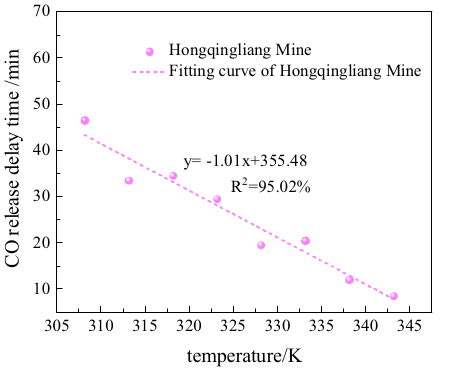
Figure 5. Fitting curve for mine sample.